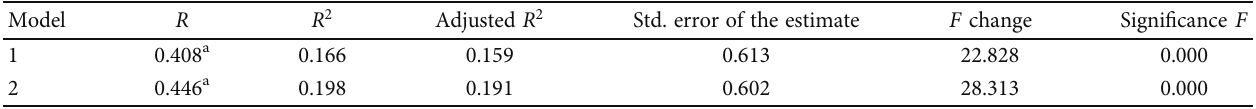
Table 11: Regression model summary b .